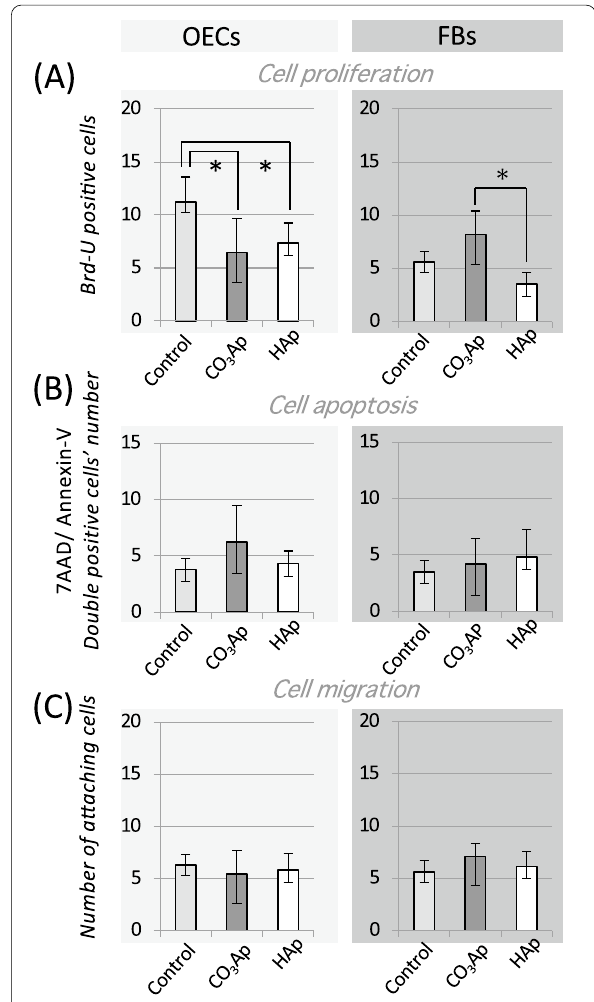
Fig. 3 Indirect effects of carbonate apatite on OECs and FBs. A BrdU assays for cell-proliferation estimation. B FACs assays for cell apoptosis estimation. The number of double-positive 7AAD and Annexin-V cells were counted. C Migration assay. The number of cells migrated from the edge of the wound was counted (n 6, * p < =